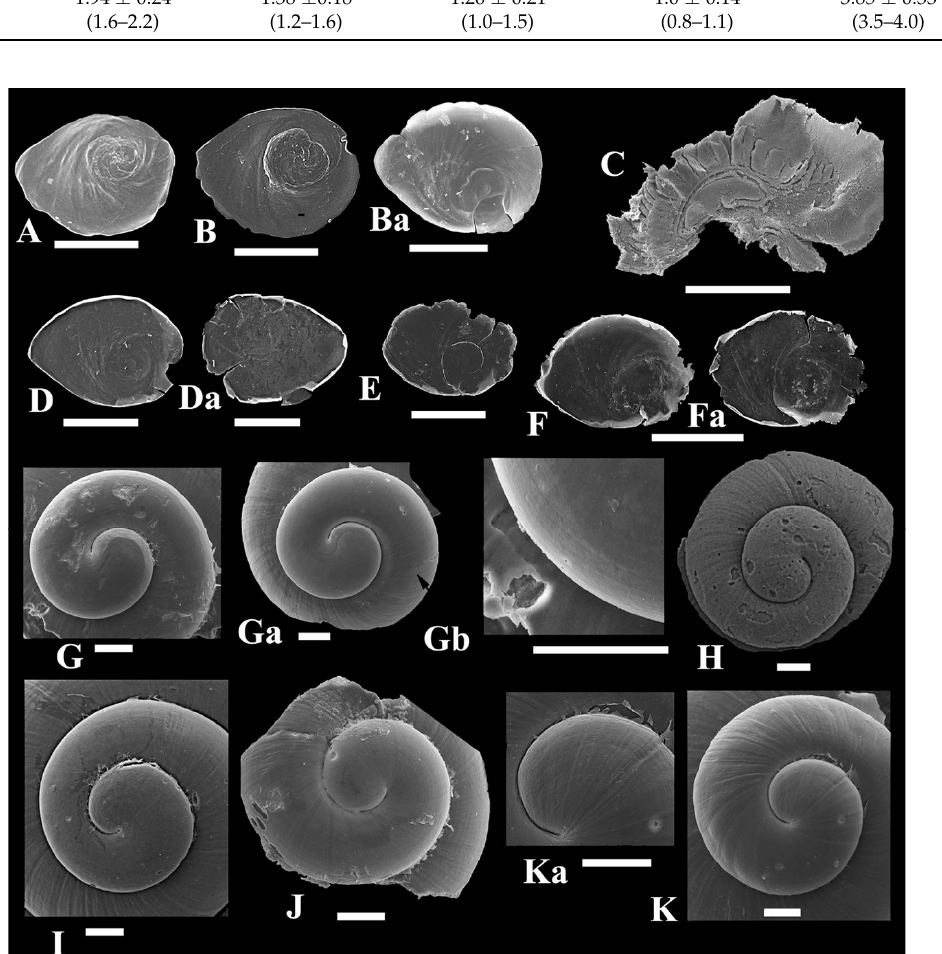
the outer marginal. No interspecific differences in radular morphology can be observed (Table 2); the variation in the number of cusps within a single radular ribbon corresponds to that observed in individuals of the same species (Figure 4D,Da).